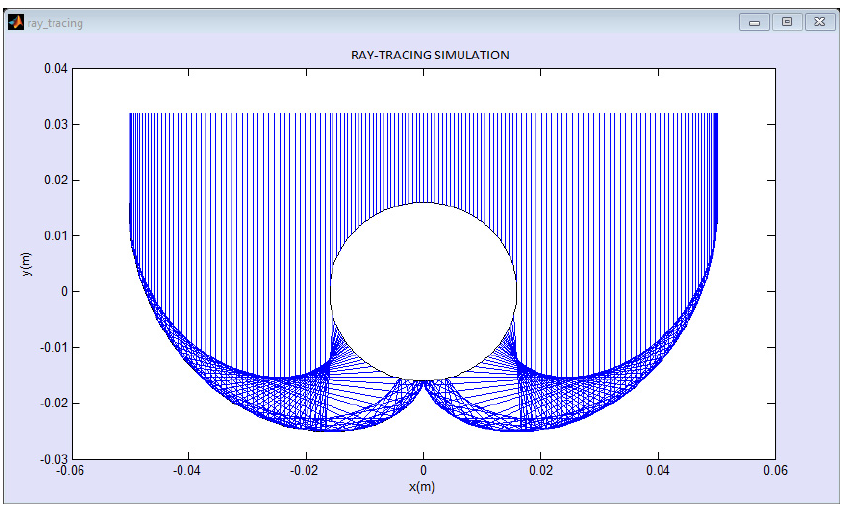
Figure 4. Ray-tracing simulation for the CPCP.